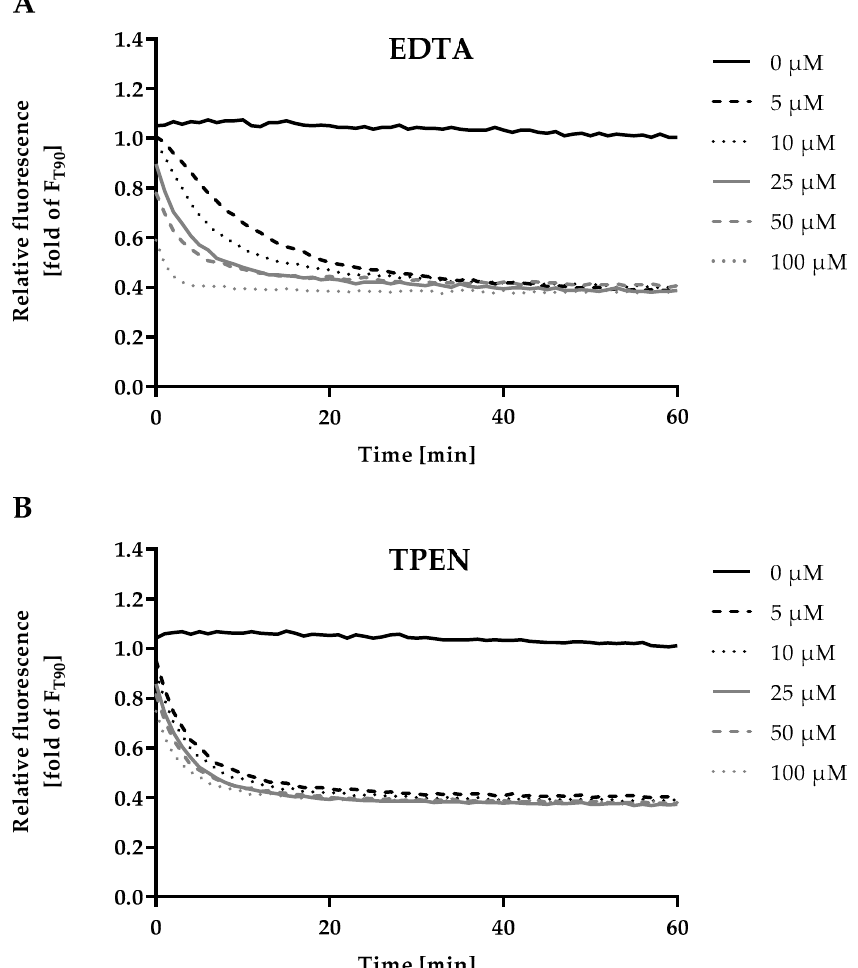
Figure 3. Kinetics of F min . The final assay procedure was performed up to the measurement of F as described in Materials and Methods and the experiment was started by addition of either ( A ) ethylenediaminetetraacetic acid (EDTA) or ( B ) N,N,N ′ ,N ′ -tetrakis(2-pyridinylmethyl)-1,2-ethanediamine (TPEN) solution (final concentrations as indicated). Fluorescence was measured in 1 min intervals for a total duration of 60 min. Data are shown relative to the value for F used in the final assay procedure, representing means of at least n = 3 independent experiments.